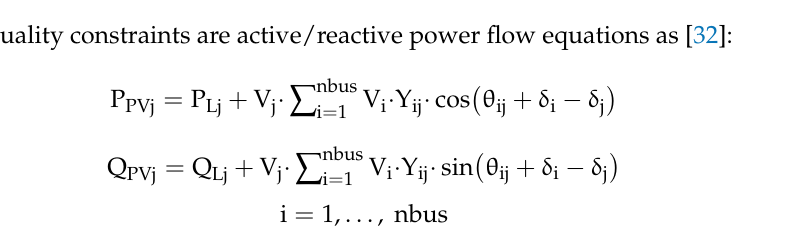
Figure 1. High-penetration PV system connected to the Power system.